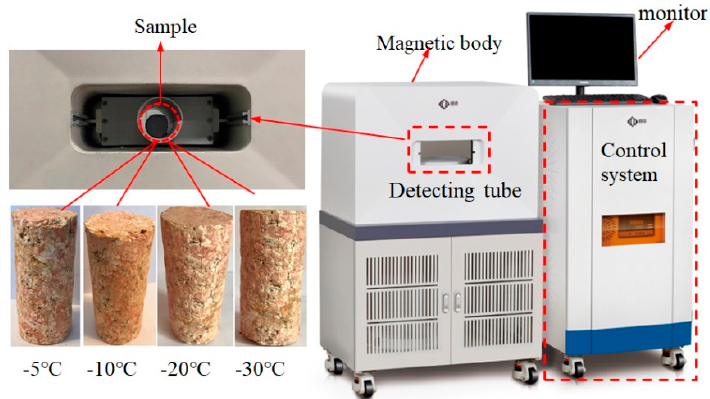
Figure 3. The photo of the NMRI equipment and the sample after freezing and thawing treatments.